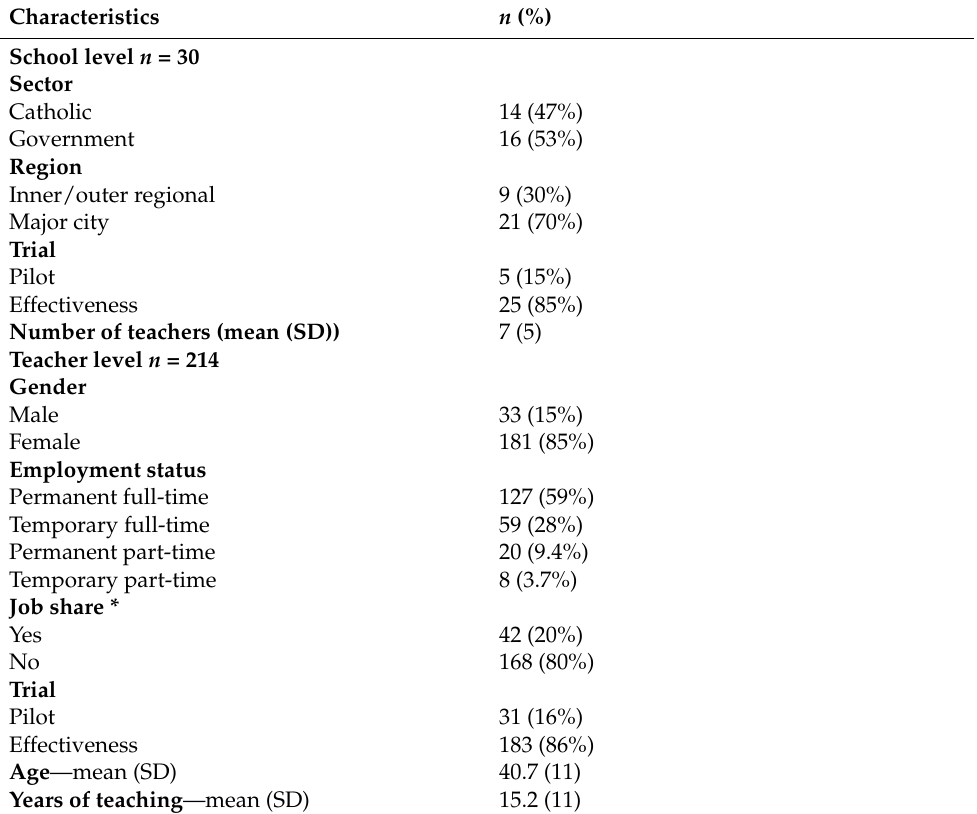
Table 1. School and teacher